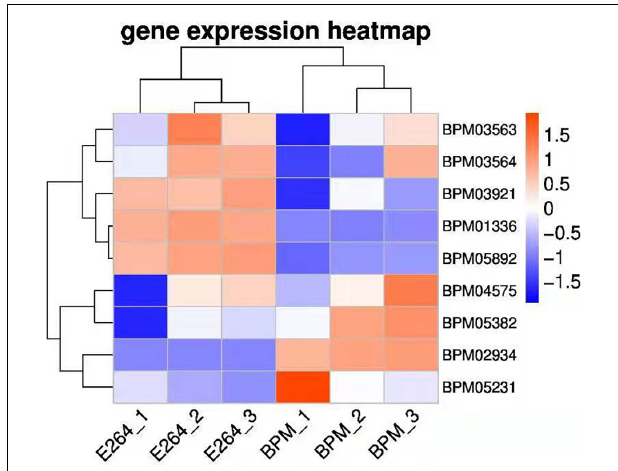
FIGURE 1 | Heatmap of vgrG gene expression in BPM and E264. Colors in the heatmap represent gene expression levels among samples. The BPM and E264 results came from three repeated samples.